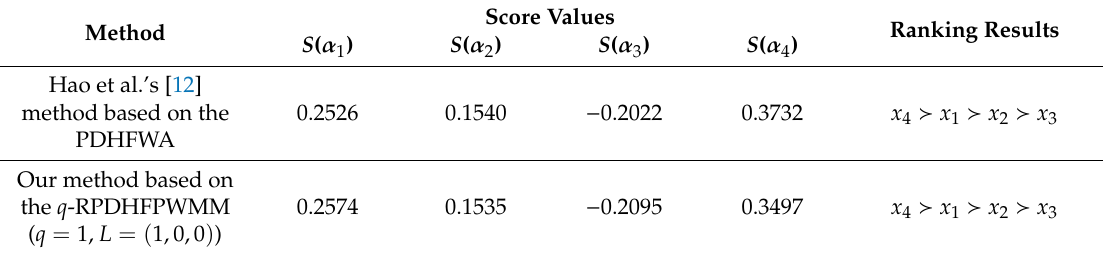
Table 8. The score values and ranking results of Example 5 by utilizing di ff erent